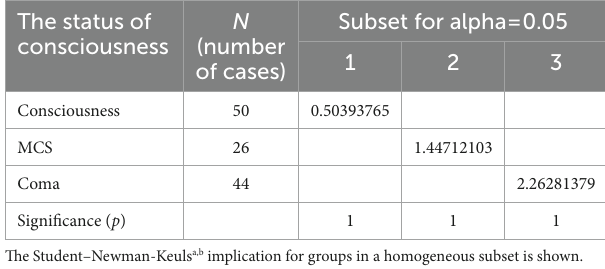
TABLE 4 Pairwise differences in hemorrhage volume and the status of